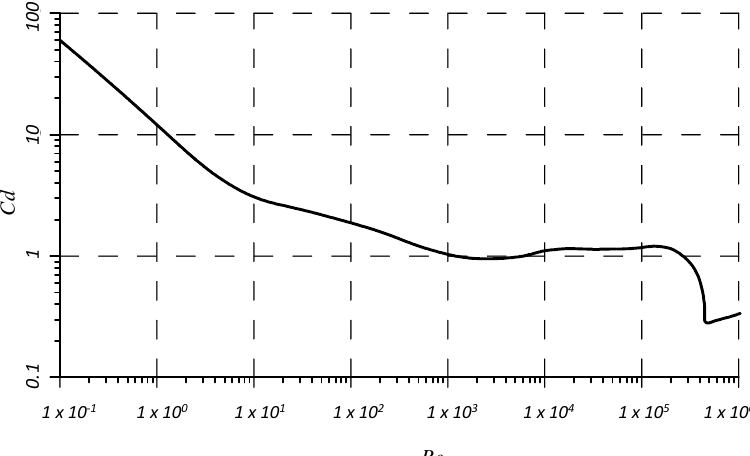
Figure 15. Drag coefficient C d for fully immersed cylinder. The figure is prepared based on